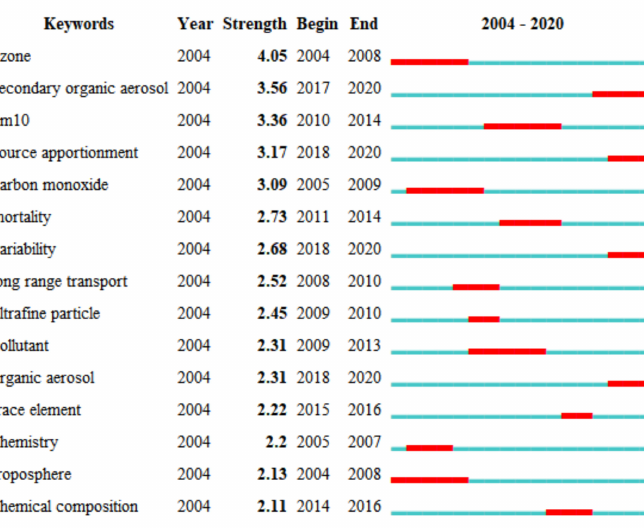
Figure 4. Keywords in the field of air pollution